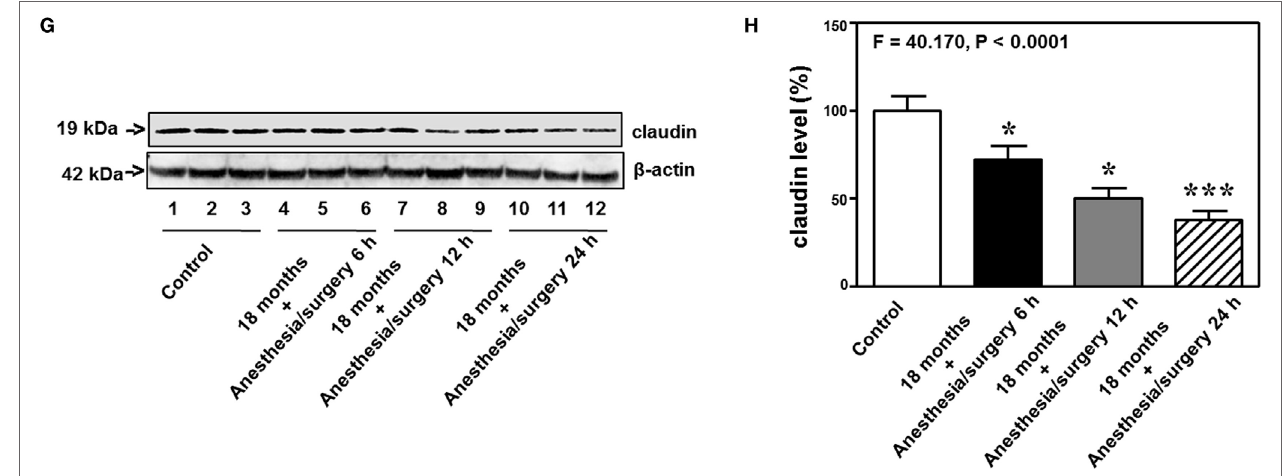
FigUre 7 | Anesthesia/surgery decreases levels of cell junction proteins. The anesthesia/surgery decreases β -catenin levels in the cortex of 18-month-old mice at 6, 12, and 24 h after the anesthesia/surgery as compared to the control condition (a,B) . The anesthesia/surgery decreases β -catenin levels in the hippocampus of 18-month-old mice at 6, 12, and 24 h after the anesthesia/surgery as compared to the control condition (c,D) . The anesthesia/surgery increases the phosphorylated β -catenin levels in the hippocampus of 18-month-old mice at 6, 12, and 24 h after the anesthesia/surgery as compared to the control condition (e,F) . The anesthesia/surgery reduces the level of claudin in the hippocampus of 18-month-old mice at 6, 12, and 24 h compared to control condition (g,h) . N = 6 in control or anesthesia/surgery